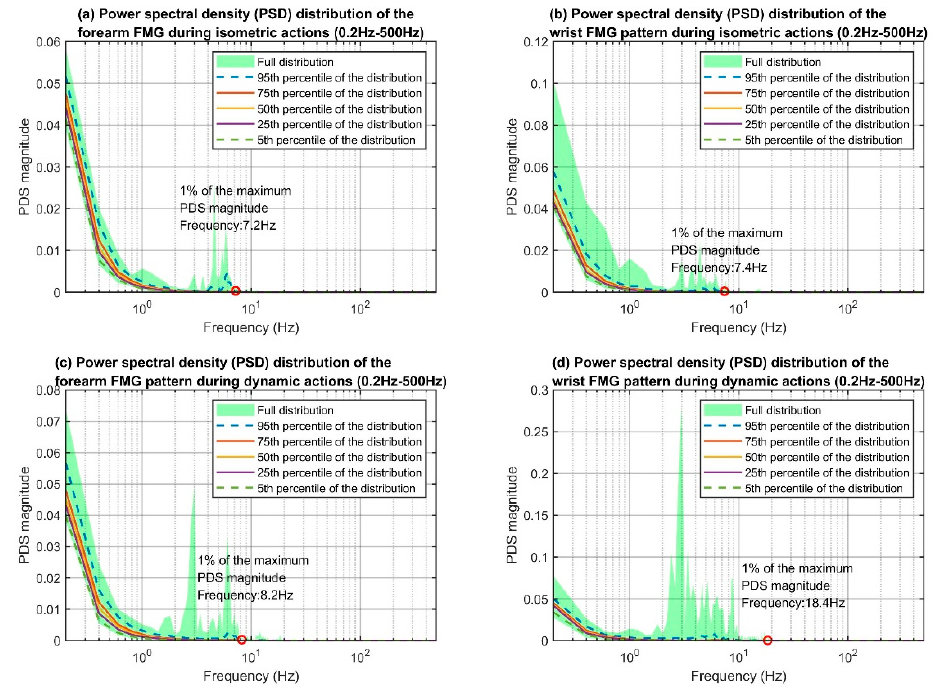
Figure A1. Maximum FMG power spectral density (PSD) distributions using Yule–Walker autoregressive method with order of 1000.